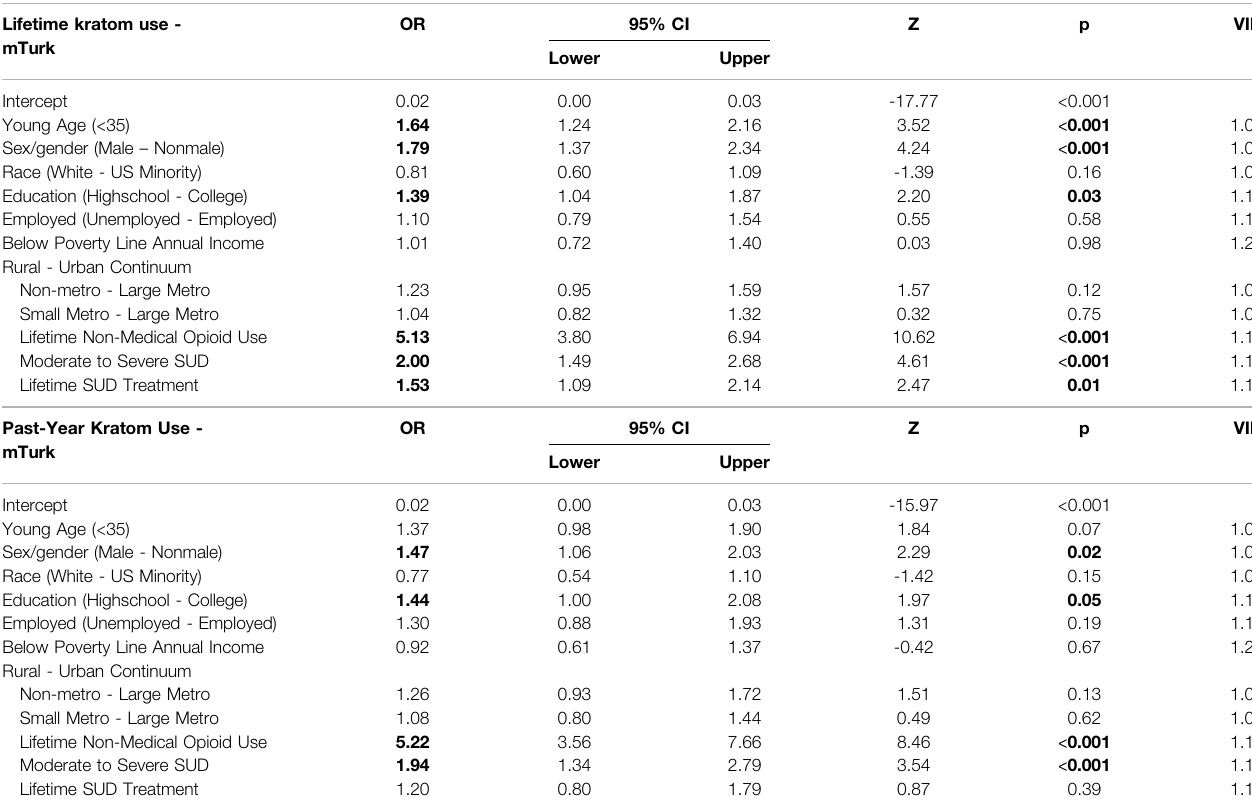
TABLE 3 | Multiple logistic regression models using online crowdsourced data to examine the relationship between county residence and kratom use while controlling for demographic and substance use factors. Lifetime kratom use -